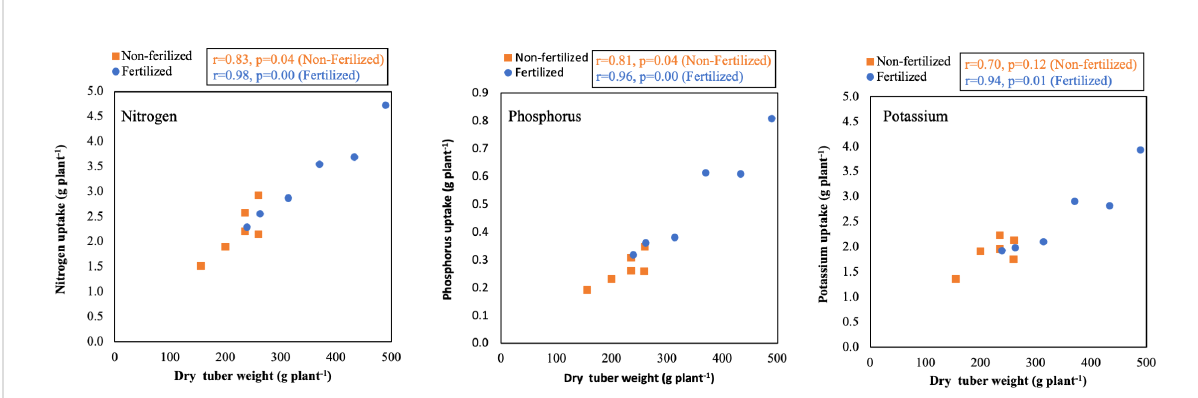
FIGURE 4 Correlation between dry tuber weight and nutrient uptake under non-fertilized and fertilized conditions in six white Guinea yam ( Dioscorea rotundata ) genotypes. Relationships for nitrogen (left box), phosphorus (centre box), and potassium (right box) uptake are